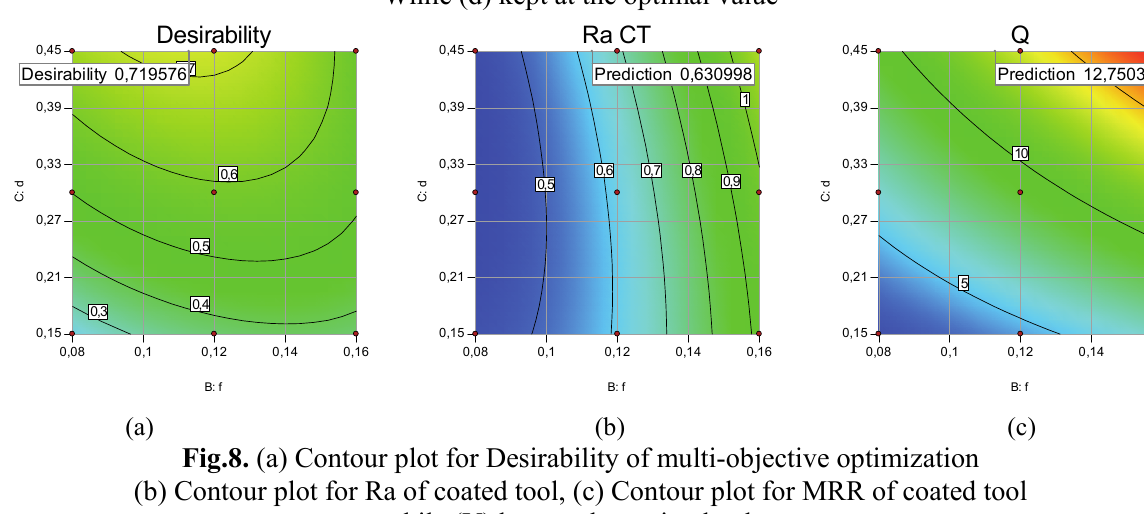
Fig.7. (a) Contour plot for Desirability of multi-objective optimization (b) Contour plot for Ra of coated tool, (c) Contour plot for MRR of coated tool, While (d) kept at the optimal value